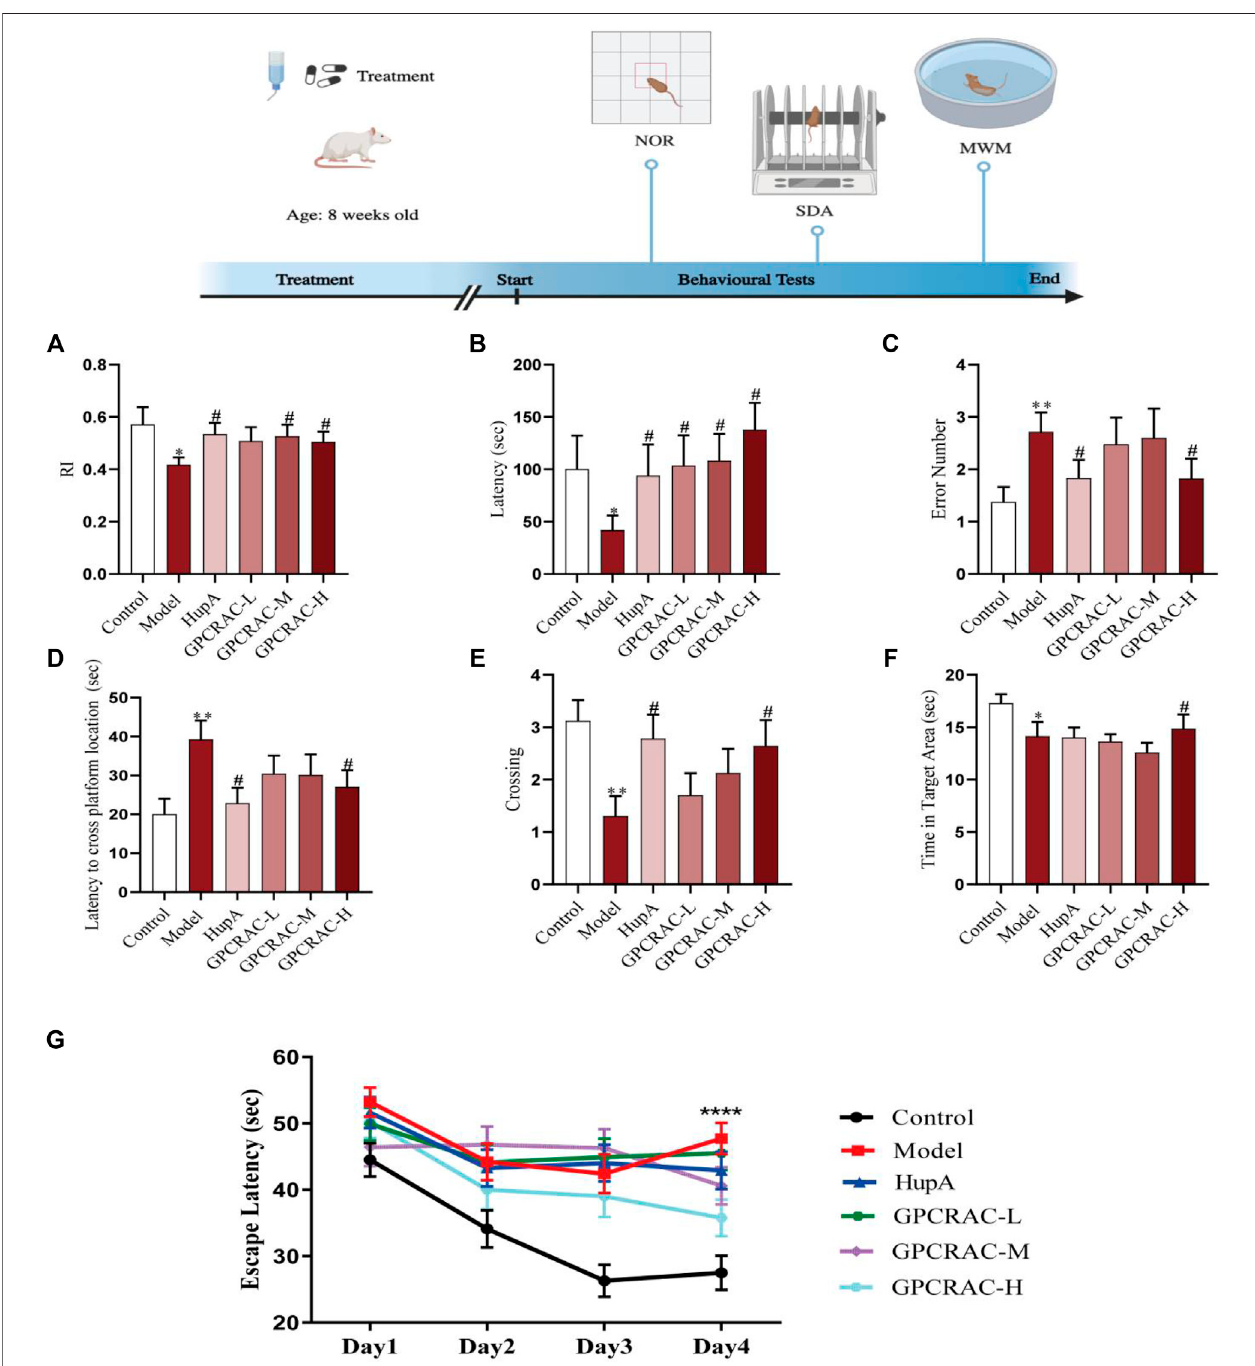
FIGURE1| AmelioratingeffectofGPCRACextractsonlearningandmemoryde fi citsinscopolamine-treatedmice.Theexplorationtimepercentageofnovelobjects (RecognitionIndexRI)innovelobjectrecognitionabilities (A) ;Thelatencyandthenumberoferrorsinstep-downpassiveavoidancetest (B,C) ;Theescapelatencyto fi nd hidden platform (D) , the numbers of crossing (E) , retention time spent in target quadrant (F) on the last day during Morris water maze; The escape latency during positioningnavigationtest(the fi rstfourconsecutivedaystraining) (G) .Dataareexpressed asmean±SE( n =17).* p < 0.05,** p < 0.01and*** p < 0.001compared to the control group; # p < 0.05, ## p < 0.01 and ### p < 0.001 compared to the scopolamine-treated group.